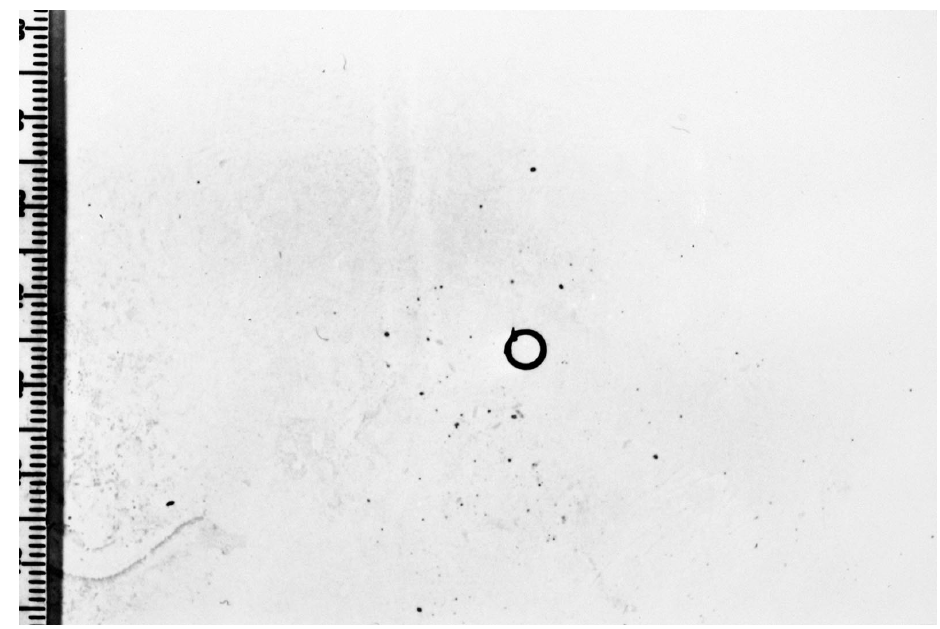
FIGURE 8 . Black and white photograph of the visualized total nitrite pattern on the adhesive lifter applied on the hairy area of the wound (before shaving) in the Fig. 7. The location of the bullet entrance hole is marked with a circle. with copper (TMJ). They found that the method allows the detection and quantification of strontium residues on the target up to a distance of 45